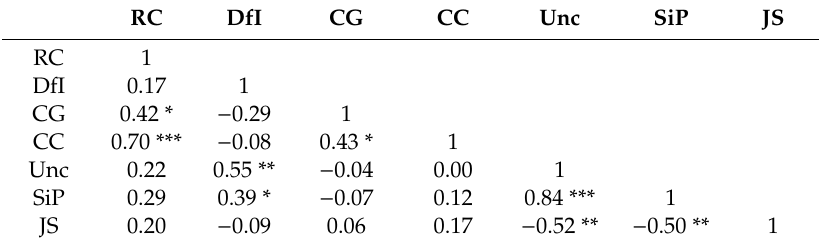
Table 4. Pearson correlations among the Reflective Practice Questionnaire (RPQ) subscales for the MSBS students in August 2018. RC DfI CG CC Unc SiP JS RC 1 DfI 0.13 1 CG 0.28 − 0.14 1 CC 0.62 *** − 0.13 0.58 ** 1 Unc − 0.33 0.23 − 0.51 ** − 0.62 *** 1 SiP − 0.27 0.01 − 0.32 − 0.42 * 0.68 *** 1 JS 0.57 ** 0.31 0.24 0.51 ** − 0.55 ** − 0.48 * 1